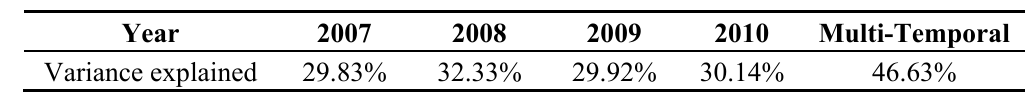
Table 1. Variance explained by the